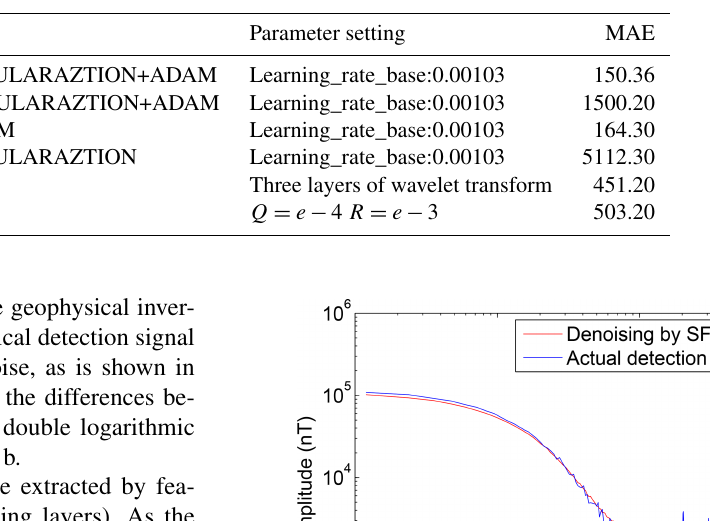
Table 2. Comparison of MAE models.